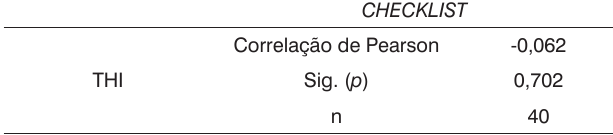
Tabela 7. Correlação entre THI e checklist